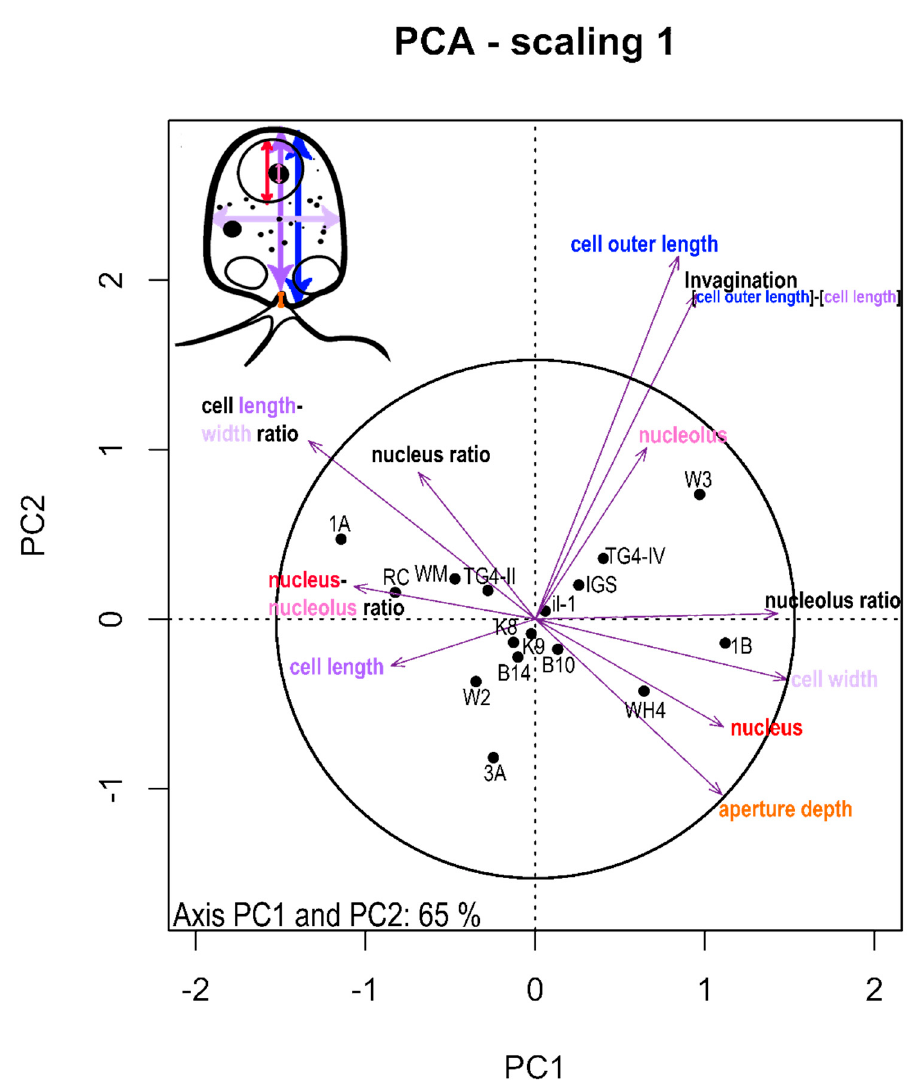
Figure 2. Principal component analysis (PCA)—Scaling 1 = distance plot; the radius of the circle of equilibrium contribution represents the length of the vector of a variable that would contribute equally to all the dimensions of the PCA space. Percentage of the total variability in the scatter plot: axis PC1: 46% and PC2: 19%. Measured morphological traits are depicted in the drawing on the upper left.